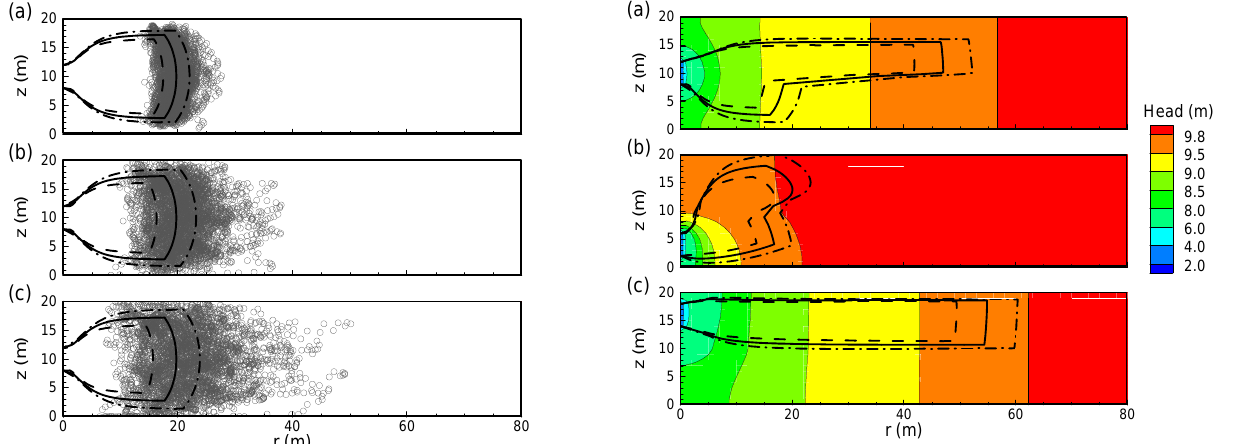
Fig. 10. Stochastic remediation zones obtained by using first-order NSM (solid lines: mean, dashed lines: mean- σ R , and dash-dotted line: mean+ σ R ) and MCS (symbols) at t = 80day for fixed r-direction correlation length ( λr ) of 5m and ln K variances of (a) 0.1, (b) 0.5, and (c) 1.0.